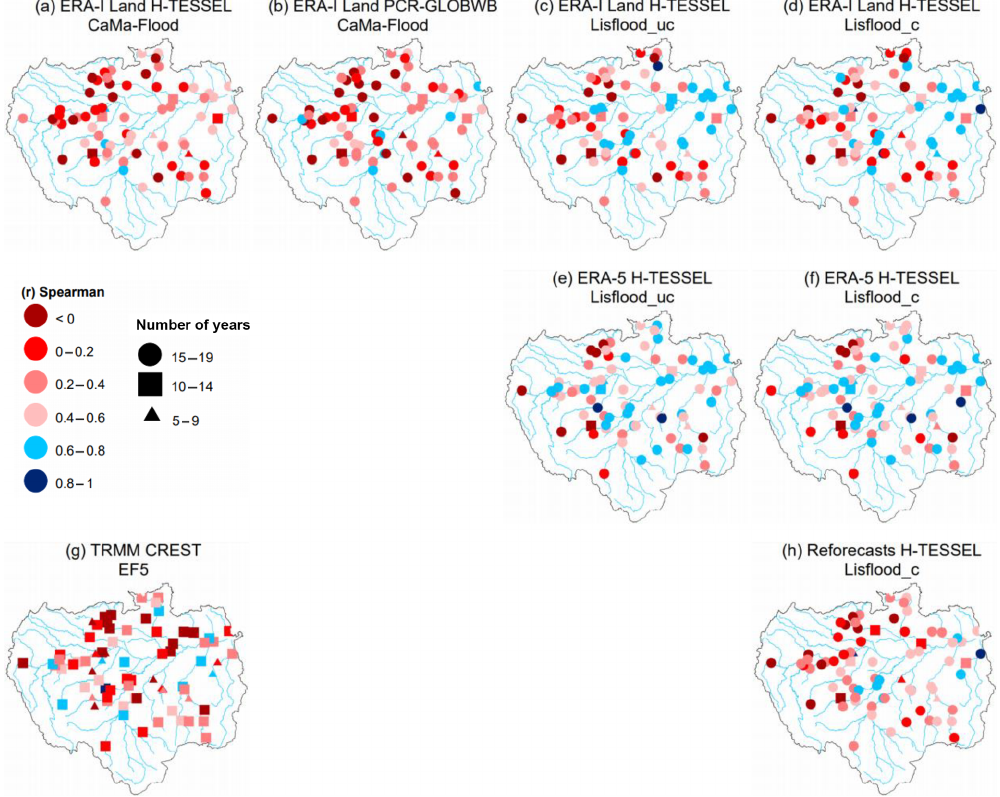
Figure 6. Spearman’s ranked correlation coefficients for observed against simulated annual maximum discharge values at the 75 hydrological gauging stations for all simulations. For the periods 1997–2015 and 2004–2015 for the Coupled Routing and Excess Storage, Ensemble Framework for Flash Flood Forecasting (CREST EF5) run (g). Values exceeding 0.6 are considered skilful (i.e. blue shapes). The number of overlapping years of data between observations and simulations are denoted by different shapes. A triangle represents 5–9 years, a square 10–14 years, and a circle 15–19 years of overlapping